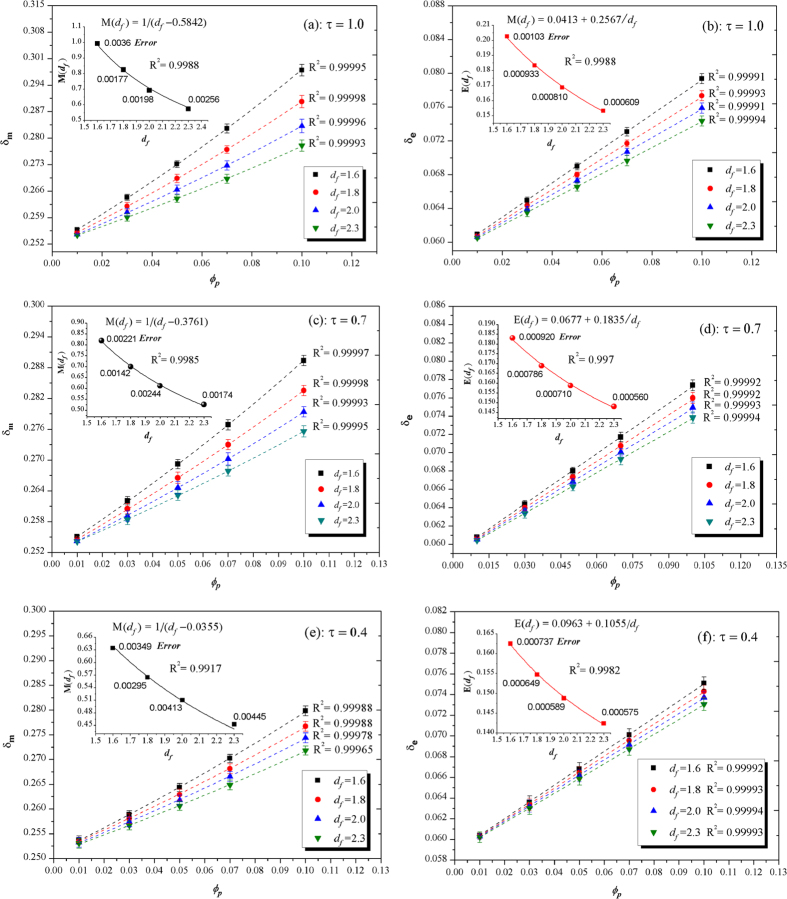
Boundary layer thickness fitting curves by fractal scaling relations.(a–f) The dimensionless momentum layer thickness δm and enthalpy layer thickness δe versus the primary volume fraction of nanoparticles ϕp for various time τ. The dashed lines are fitting results for δm and δe data with high degree R2 > 0.999. The solid lines in inside figures are also fitting results for M(τ, df) and E(τ, df) data, and all errors are the relative errors.